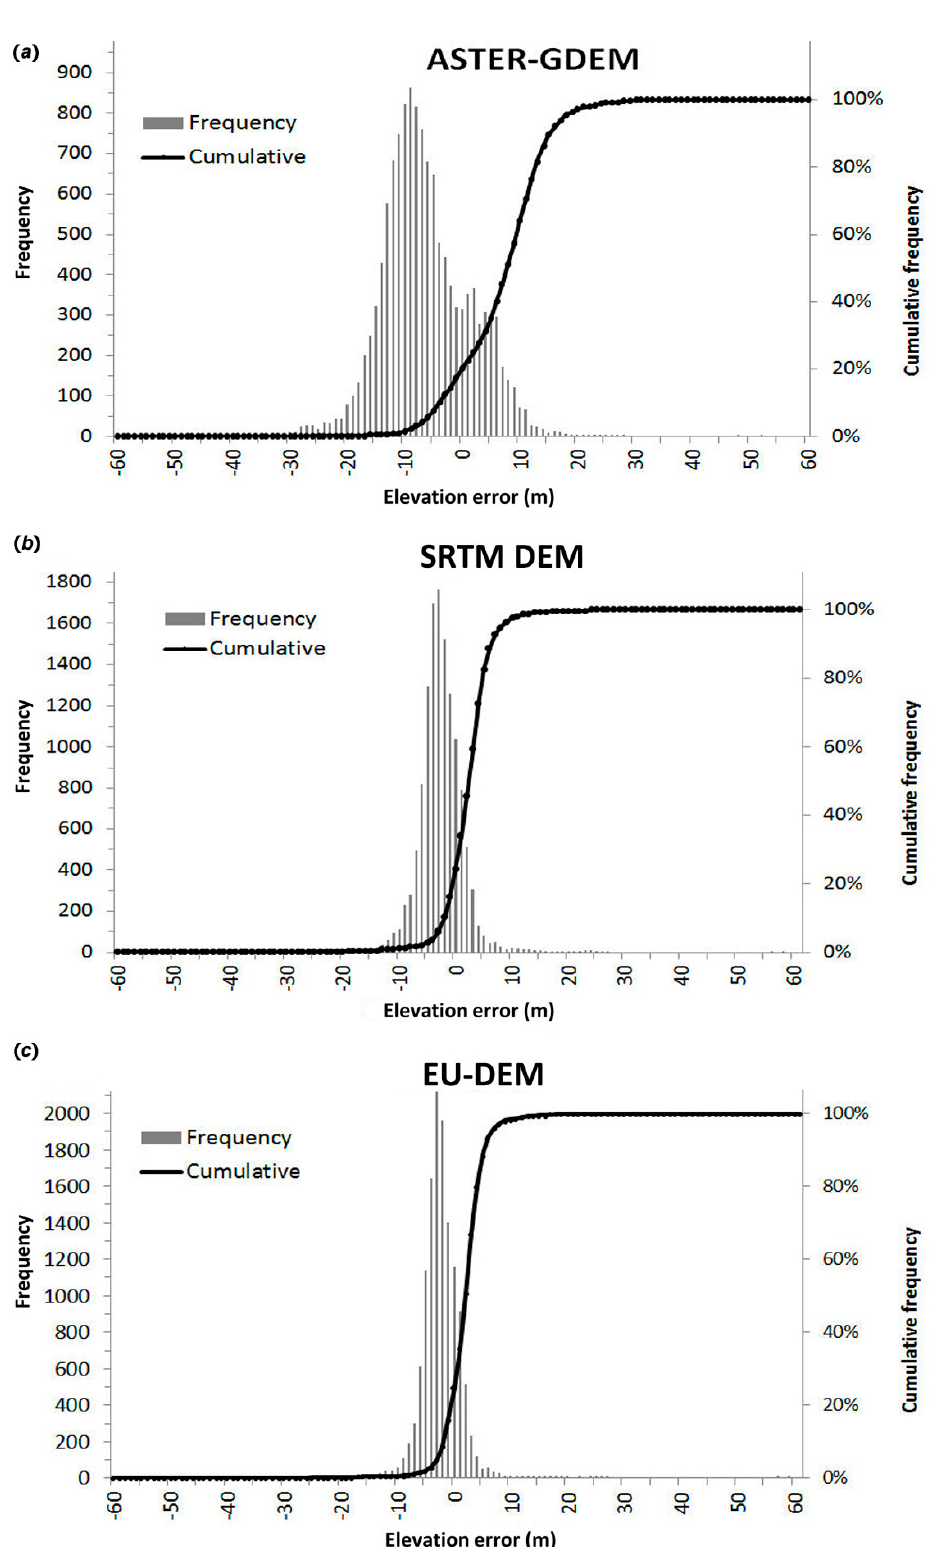
Figure 4. Histograms of absolute elevation errors for the three DEMs: (a) ASTER-GDEM, (b) SRTM DEM and (c) EU-DEM